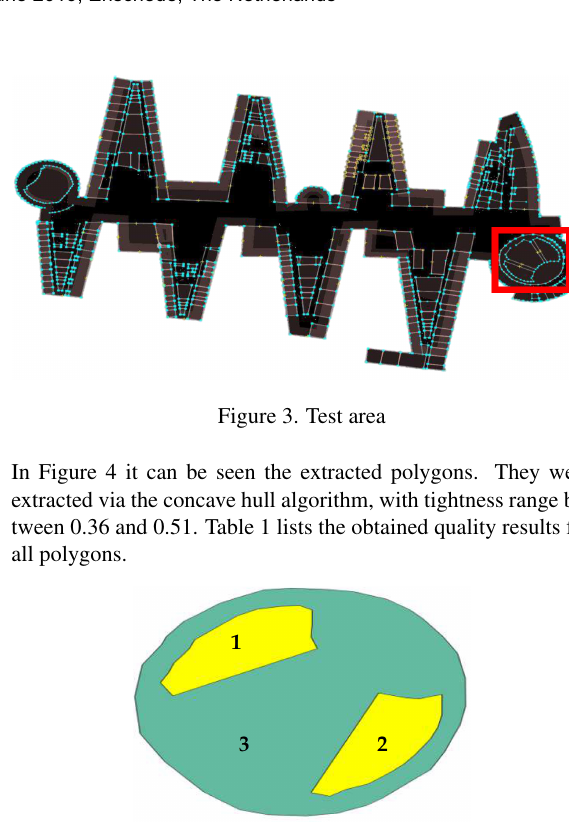
Figure 4. Polygons extracted in test area via the concave hull